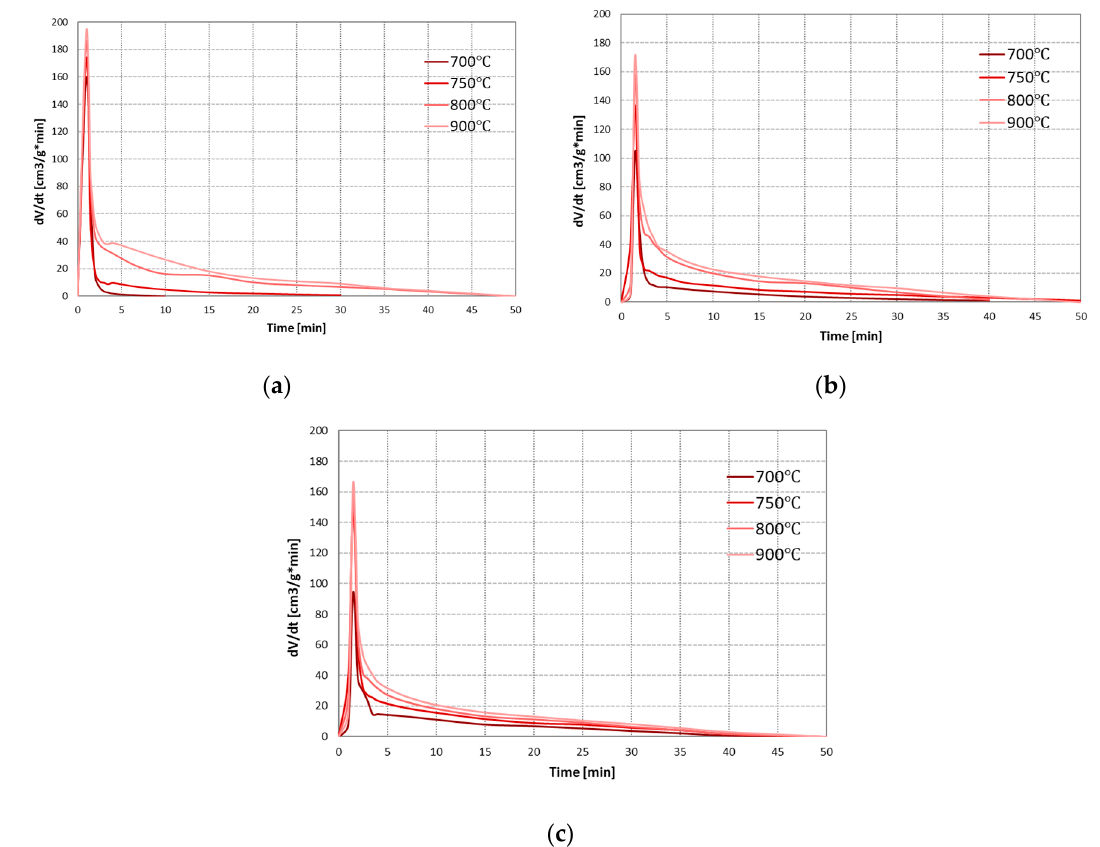
Figure 7. Changes in the formation rates of CO during CO 2 gasification of RDF at various temperatures and under: ( a ) 0.5 MPa; ( b ) 1 MPa; ( c ) 1.5 MPa.